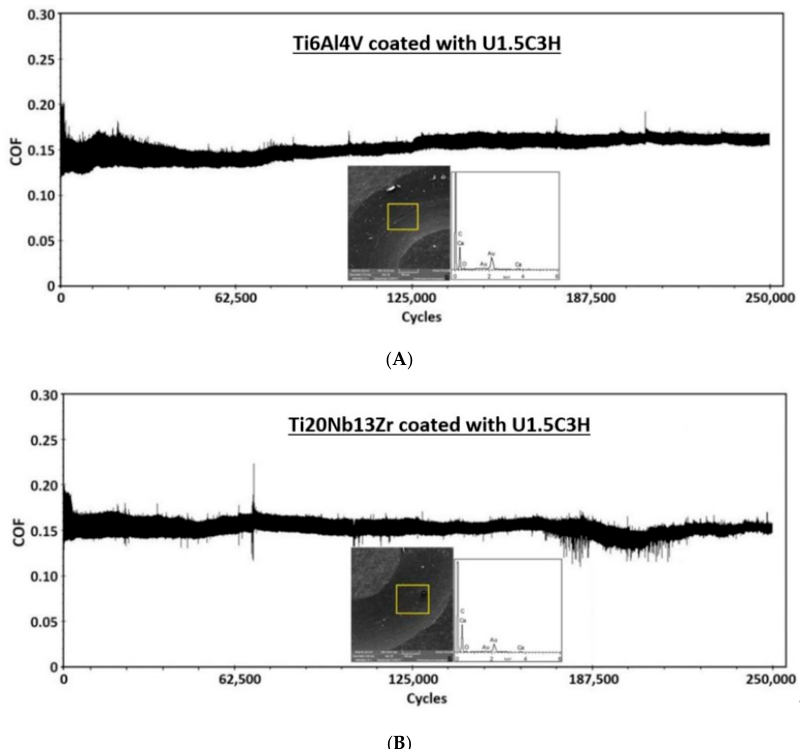
Figure 12. Typical COF graph, SEM images of wear track and EDX analysis of hybrid nanocomposite coating deposited on ( A ) Ti6Al4V ( B ) Ti20Nb13Zr, recorded after a wear test performed at a normal load of 12N and a sliding velocity of 0.1 m/s for 250,000 cycles.